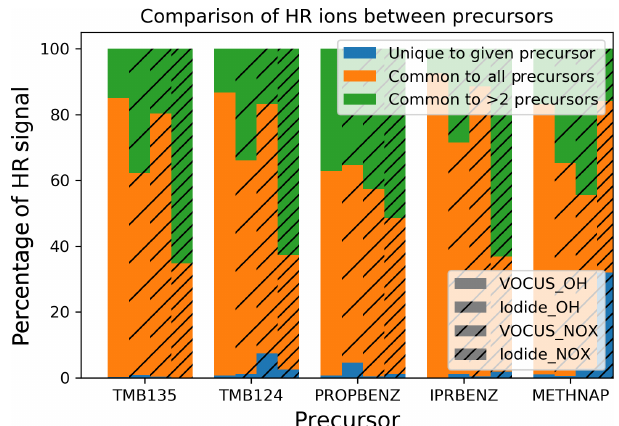
Figure 6. Comparison of signal contributions of ions which were commonly observed from all precursors (orange), ions common to two or more precursors (green) and ions unique to the given precur- sor (blue) for all precursors and